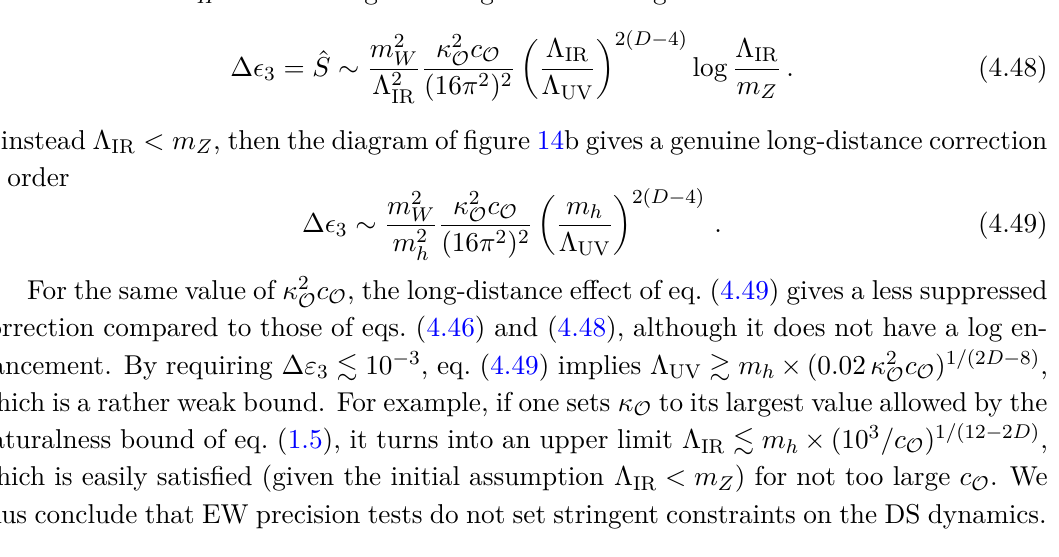
is denoted by a crossed vertex, and the H